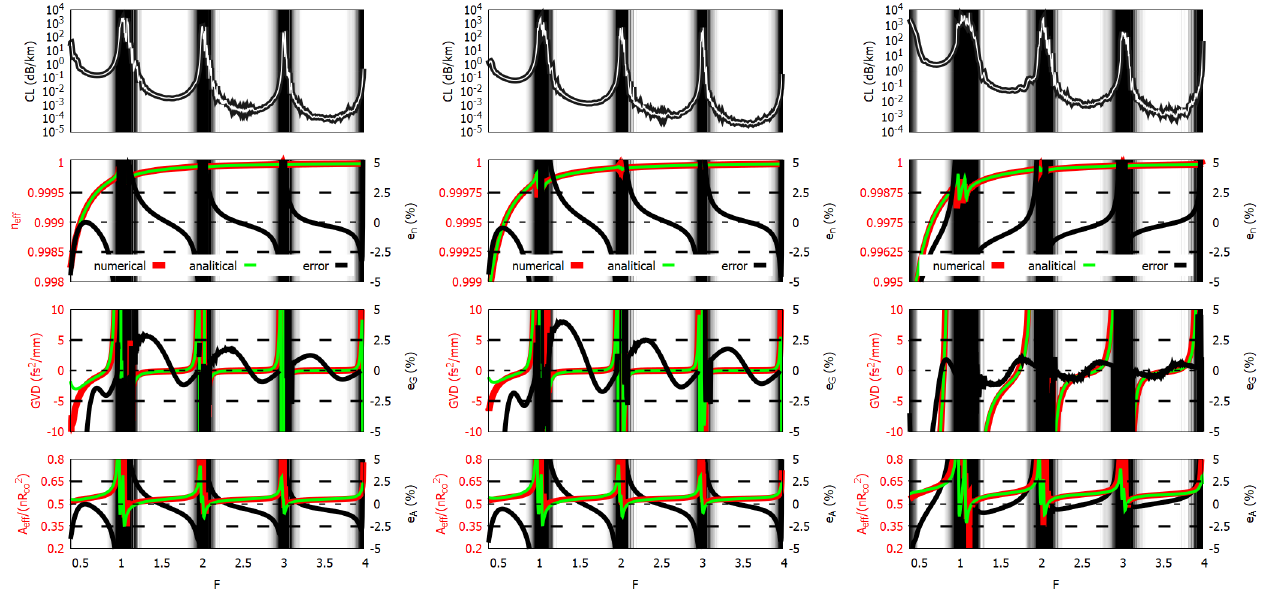
Figure 6. Confinement loss ( top row ), effective index ( top-central row ), group velocity dispersion ( bottom-central row ), and effective area ( bottom row ) of fibers F#5 ( left ), F#6 ( central ), and F#7 ( right ). Dark areas correspond to high-loss regions. For effective index, group velocity dispersion, and effective area, solid green, red, and black curves show numerical and analytical result, and relative error, respectively.